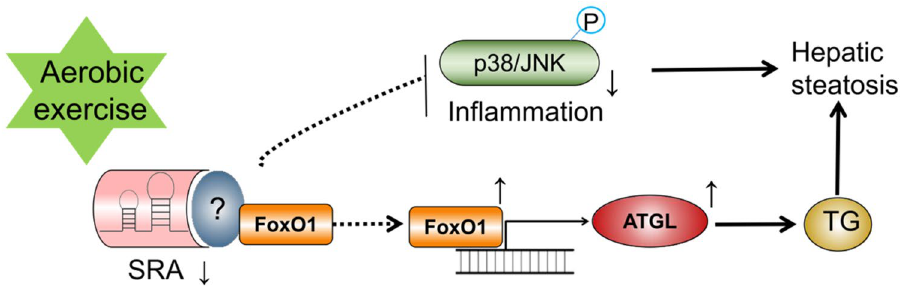
Figure 5. Aerobic exercise via SRA improves hepatic steatosis description model. Aerobic exercise is closely linked to the reduction of intrahepatic lipid aggregation and inflammatory responses through the inhibition of SRA levels. Mechanistically, aerobic exercise may inhibit the transcriptional activity of FoxO1 by suppressing SRA expression, which leads to upregulation of ATGL expression. In addition, remission of inflammation was accompanied by significant alteration of inflammatory proteins and the P38/JNK signaling